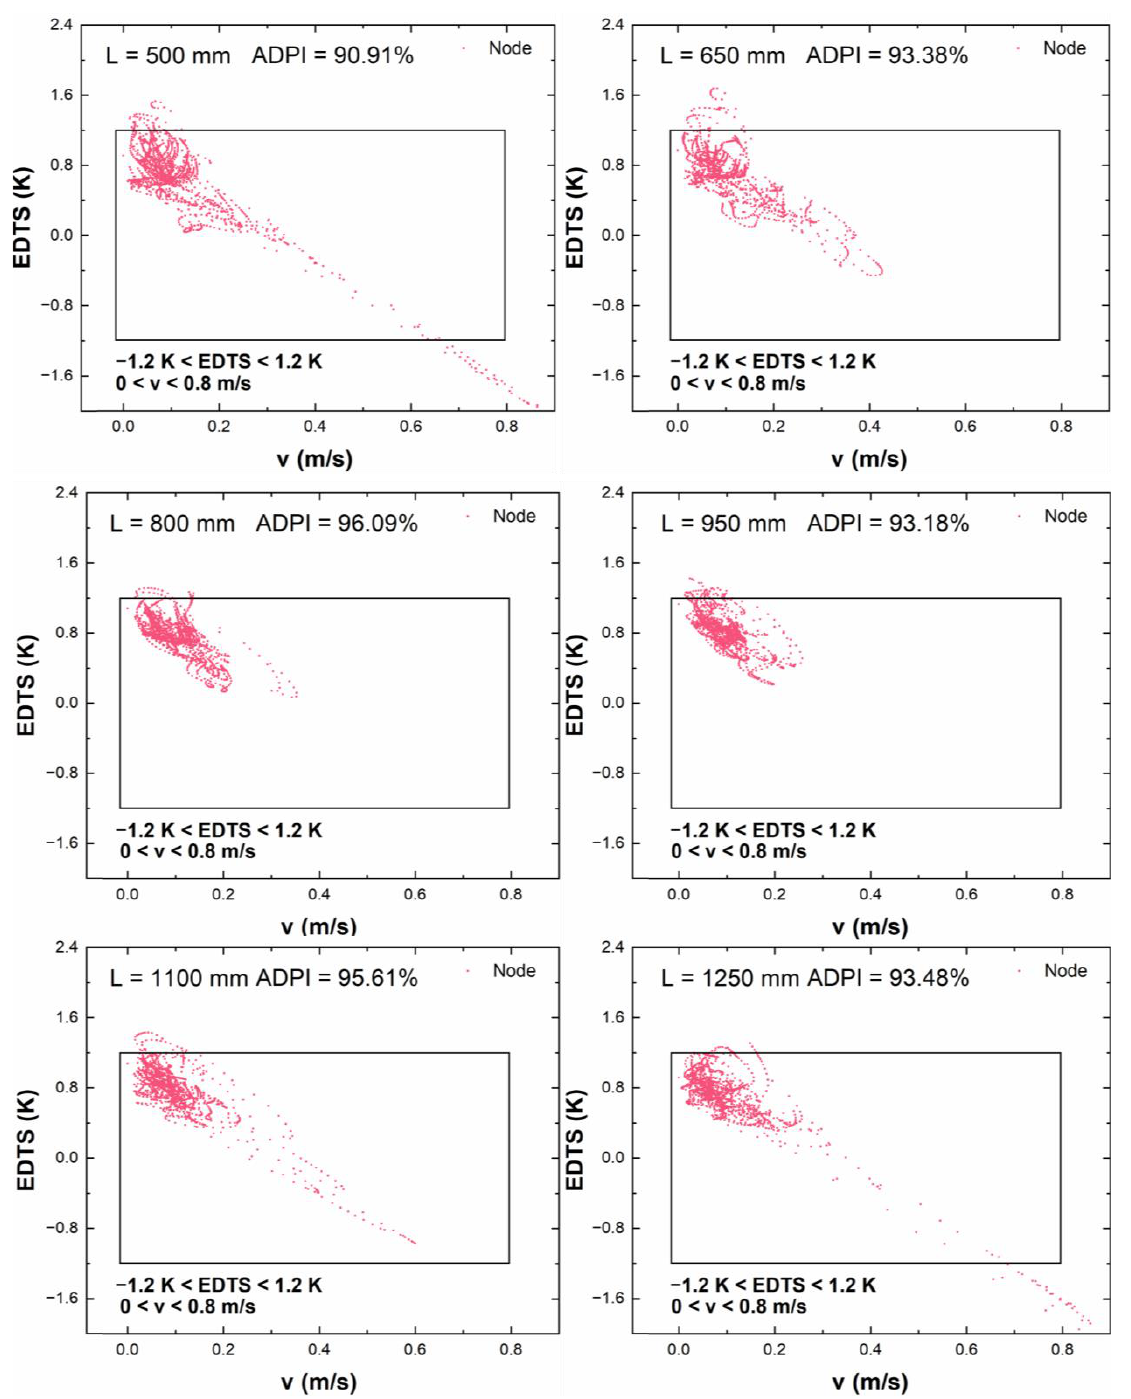
Figure 13. ADPI distribution in EDTS – velocity diagram with different air inlet spacings.